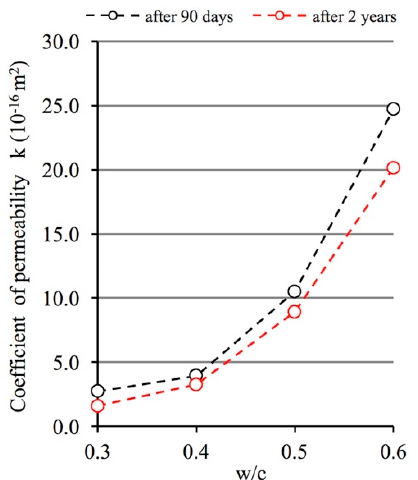
Figure 7. Relationship between permeability and the w/c ratio of cement pastes after 90 days and 2 years of curing.